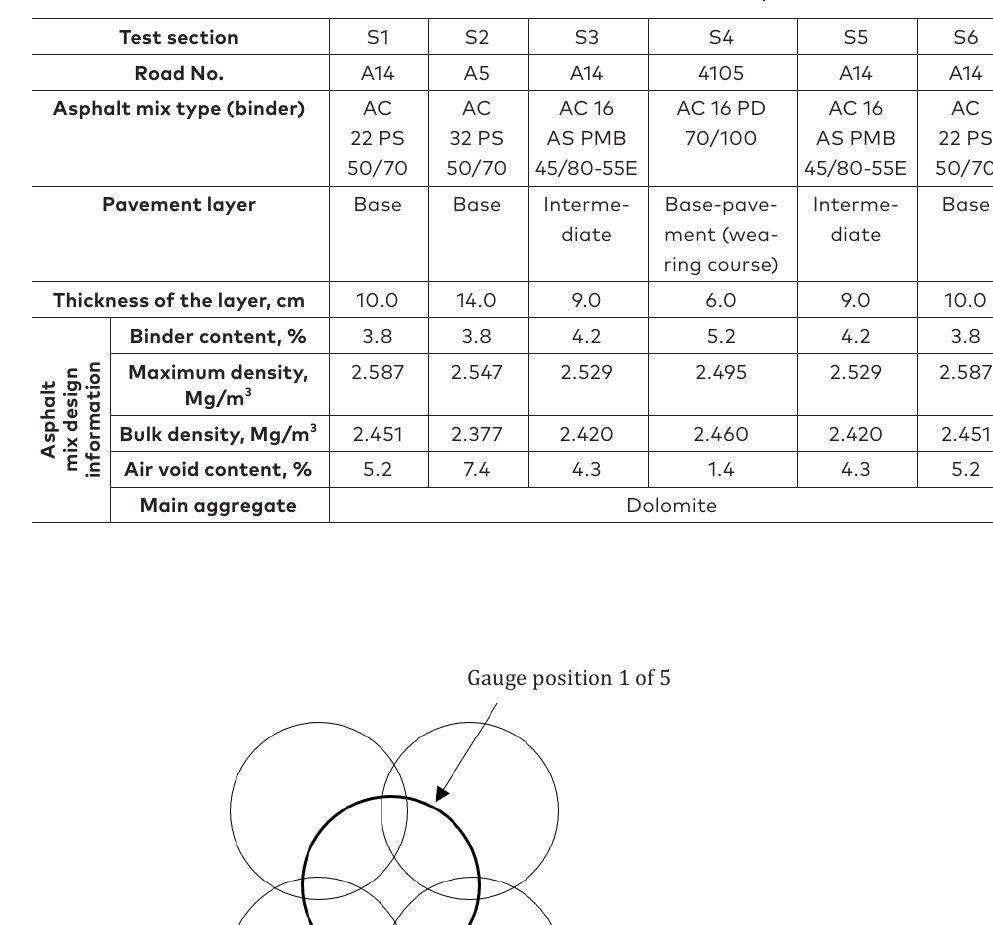
Table 1 . Test sites and asphalt mixture